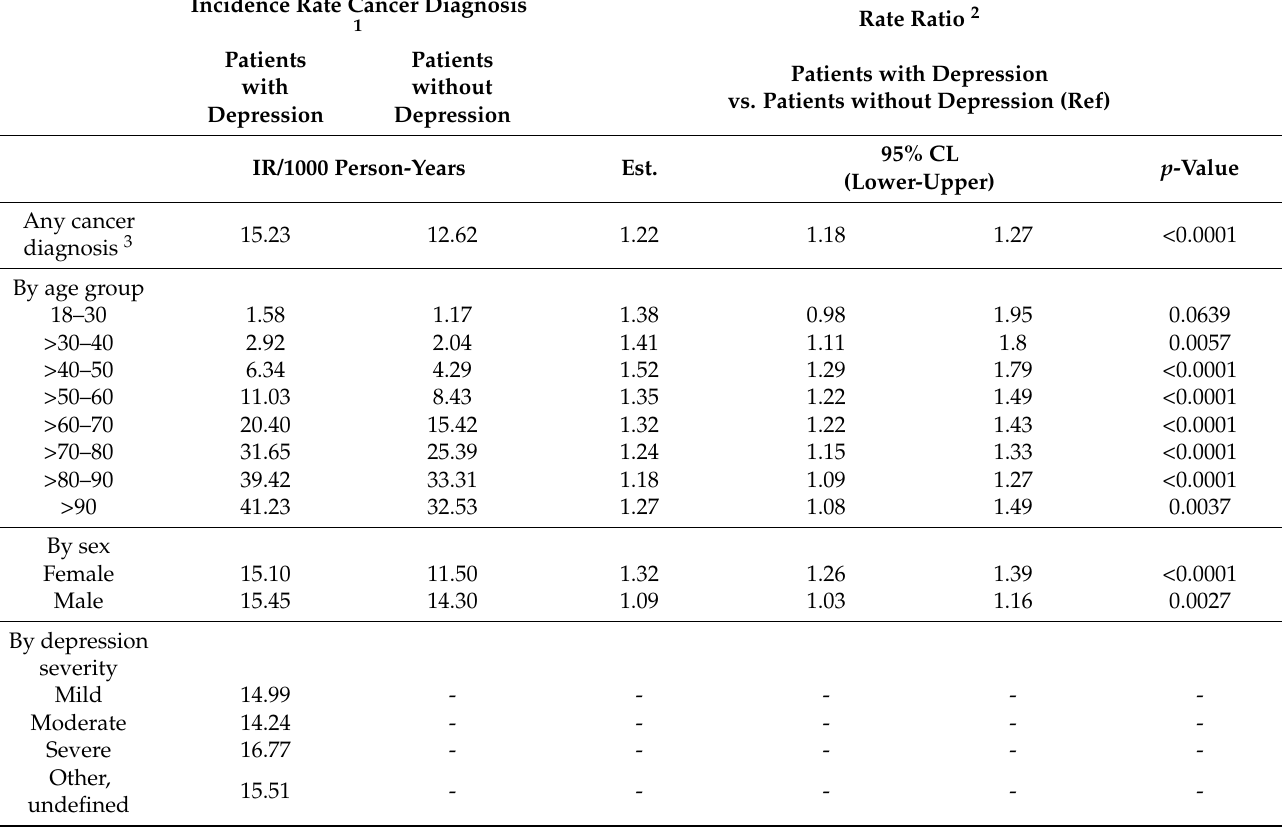
Table 3. Incidence rate of cancer diagnosis by group, subgroup, and type of